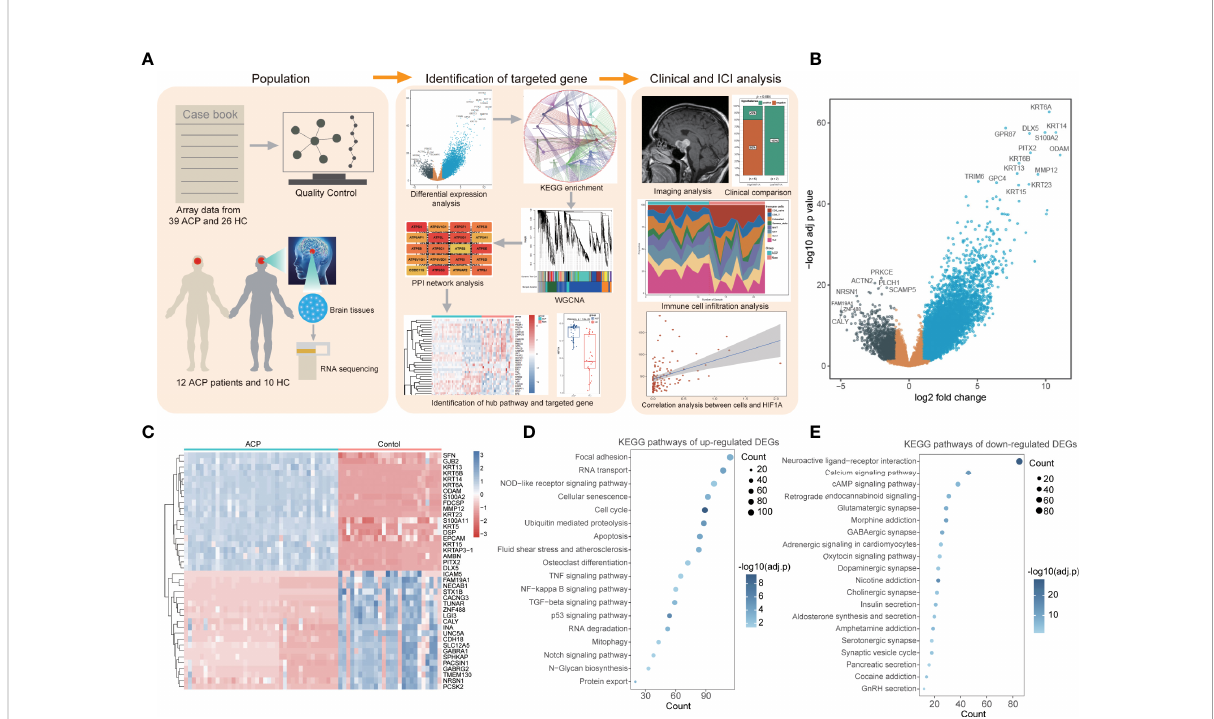
FIGURE 1 Identi fi cation of differentially expressed genes (DEGs) and functional enrichment in adamantinomatous craniopharyngiomas (ACPs). (A) . The work fl ow of the whole process in this study. (B) . The volcano map displayed a total of 8,568 DEGs including 7,247 upregulated and 1,321 downregulated genes. (C) . The heatmap of top 20 DEGs exhibited amazing discriminative capacity between ACP patients and control cohorts. (D, E) . The KEGG enrichment analysis revealed that most upregulated DEGs were enriched in the cell biological process and immune-activated signaling pathways. (D) while downregulated signatures were majorly enriched in the secernent disorder of multiple hormones and signal regulation pathways (E)